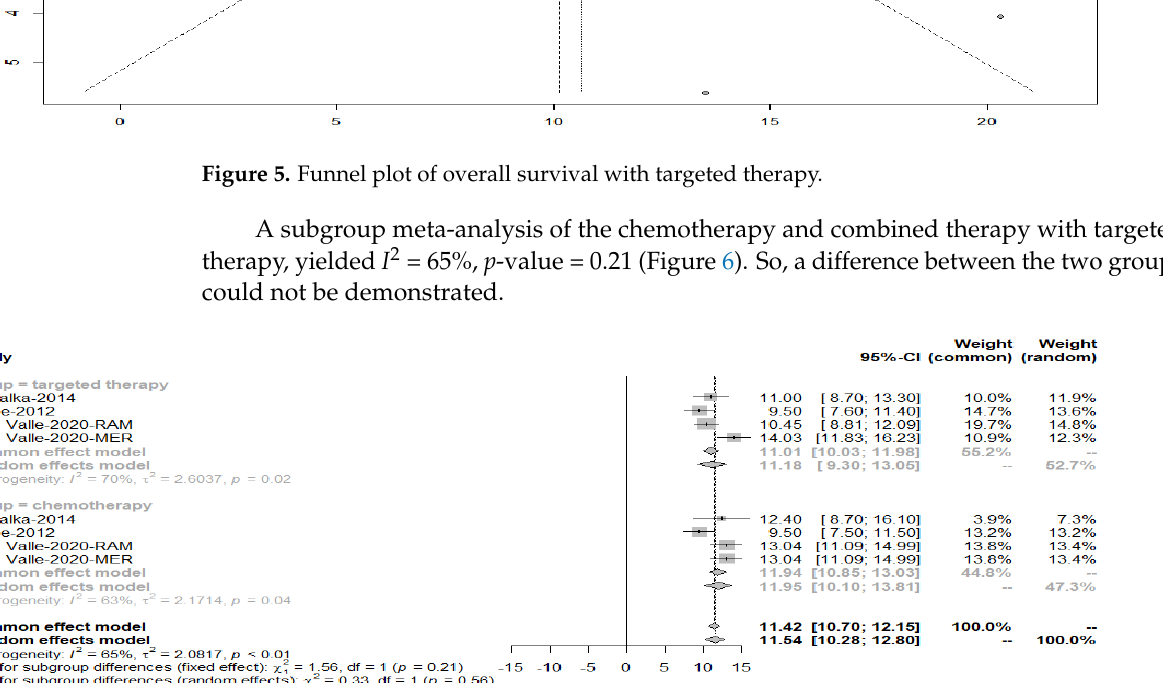
Figure 6. Overall survival in the targeted chemotherapy combination group compared with the chemotherapy alone group.